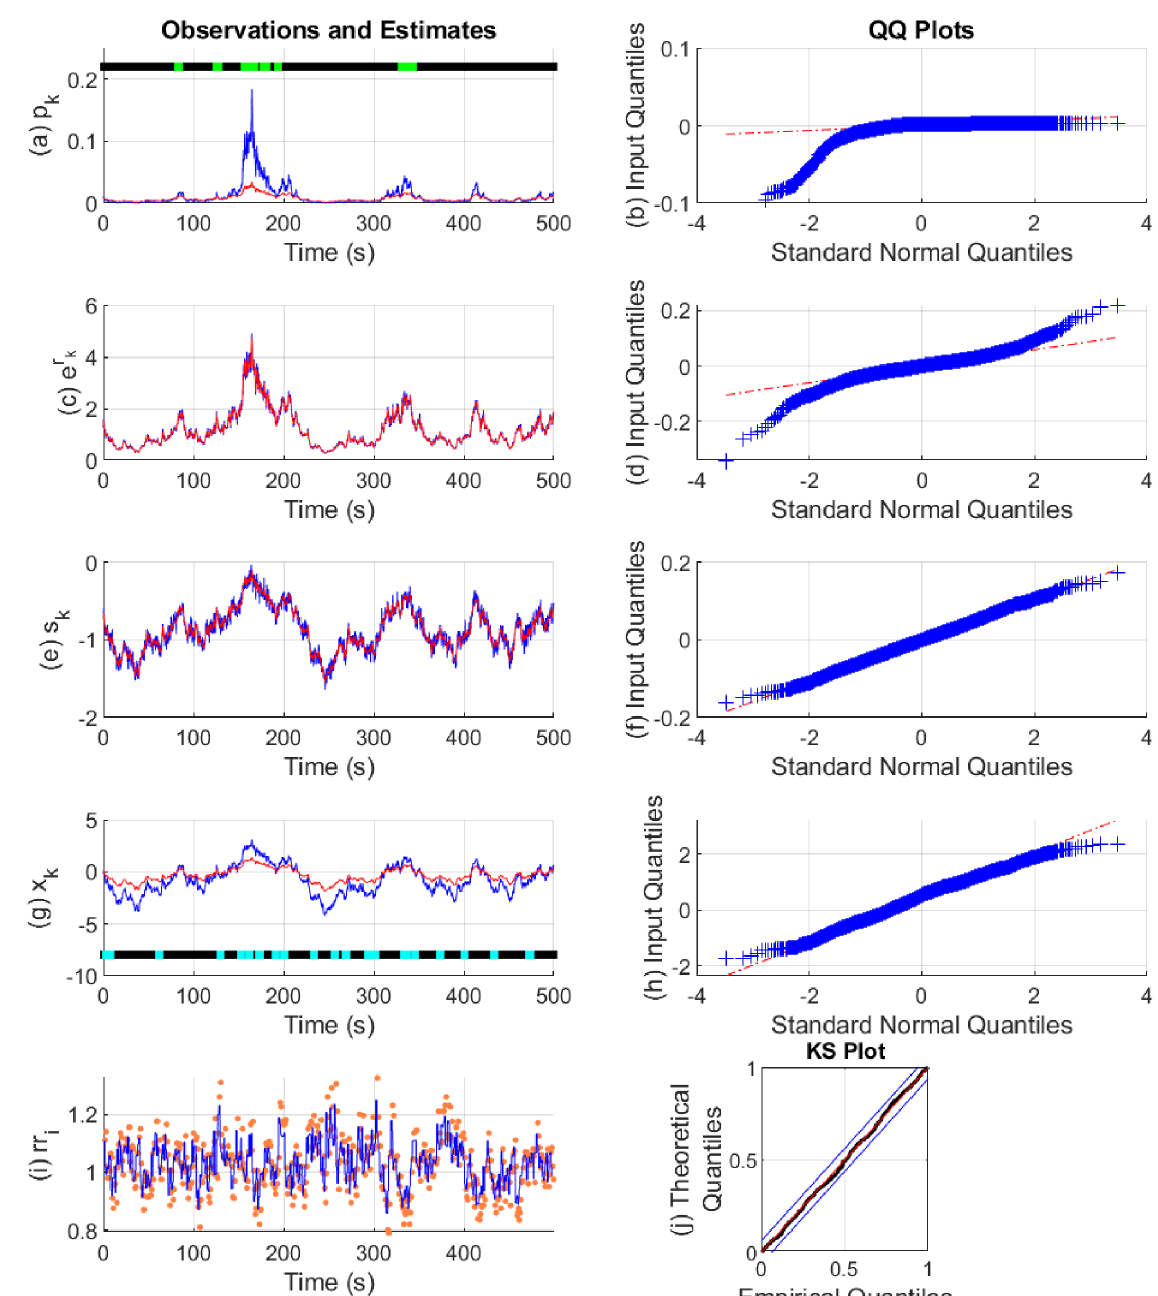
Fig 7. State estimation with simulated data ( ^ p < 0 : 01 ). The sub-panels respectively depict, (a) the Bernoulli trial probabilities p k (blue), their 0 estimate (red) and the presence or absence of binary observations (light green and black dots); (b) the QQ plot for the residual error of p the exponent of r k (blue) and its estimate (red); (d) the QQ plot for the residual error of r k ; (e) s k (blue) and its estimate (red); (f) the QQ plot for the residual error of s ; (g) the arousal state x (blue), its estimate (red) and the presence or absence of stimuli I k k blacks dots); (h) the QQ plot for the residual error of x k ; (i) the sequence of RR-intervals rr i (orange dots) and the estimated RR-interval mean μ (solid blue line); (j) the KS plot for the